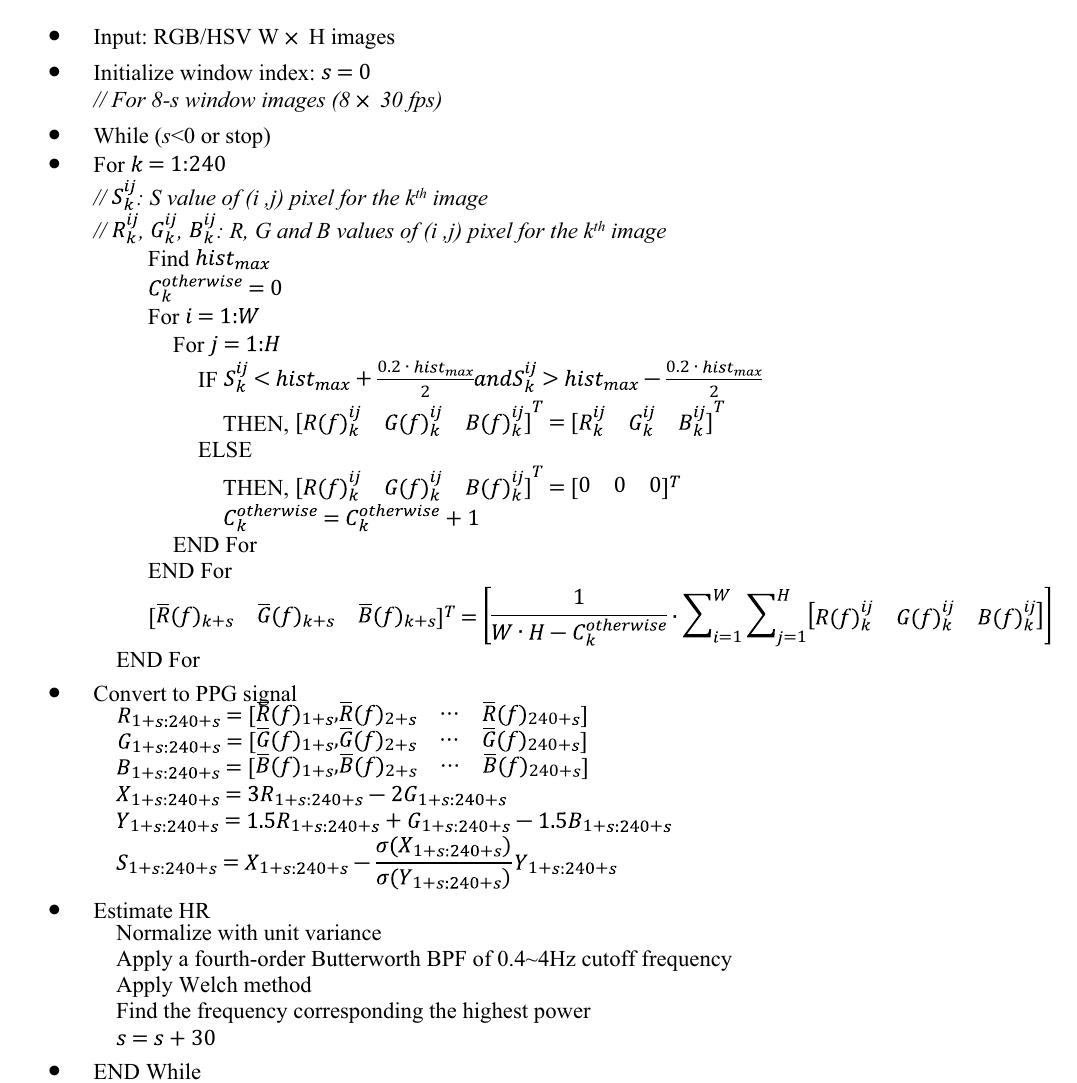
Algorithm 1: Heart rate estimation method using RSVR